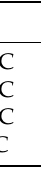
Table 3. Magnet, Temperature of use